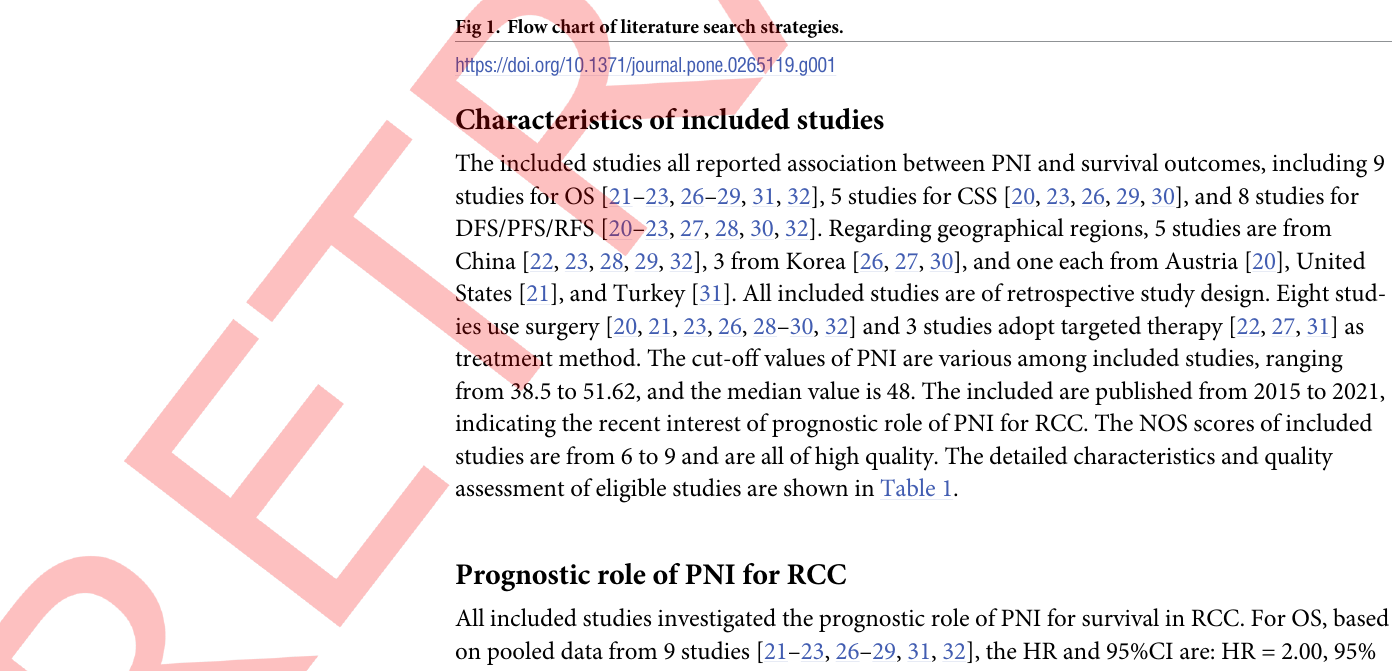
Fig 1. Flow chart of literature search